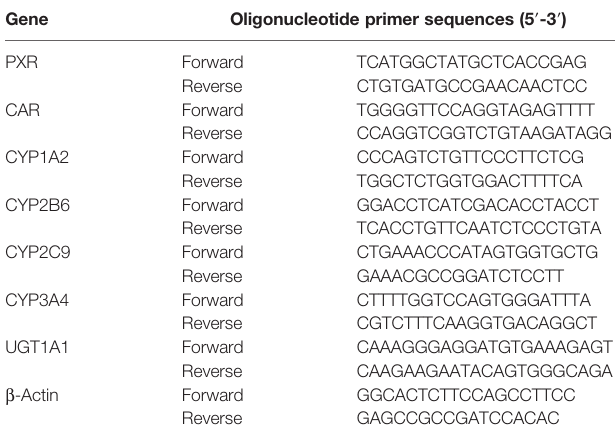
TABLE 2 | HepG2 primers used for real-time PCR analysis.